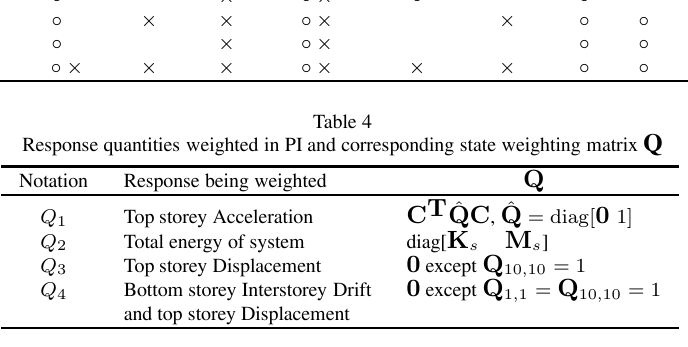
Table 5 Maximum peak/RMS response for various sensor con fi gurations, one damper, (Drift/Displ - cm, Accel - cm/s 2